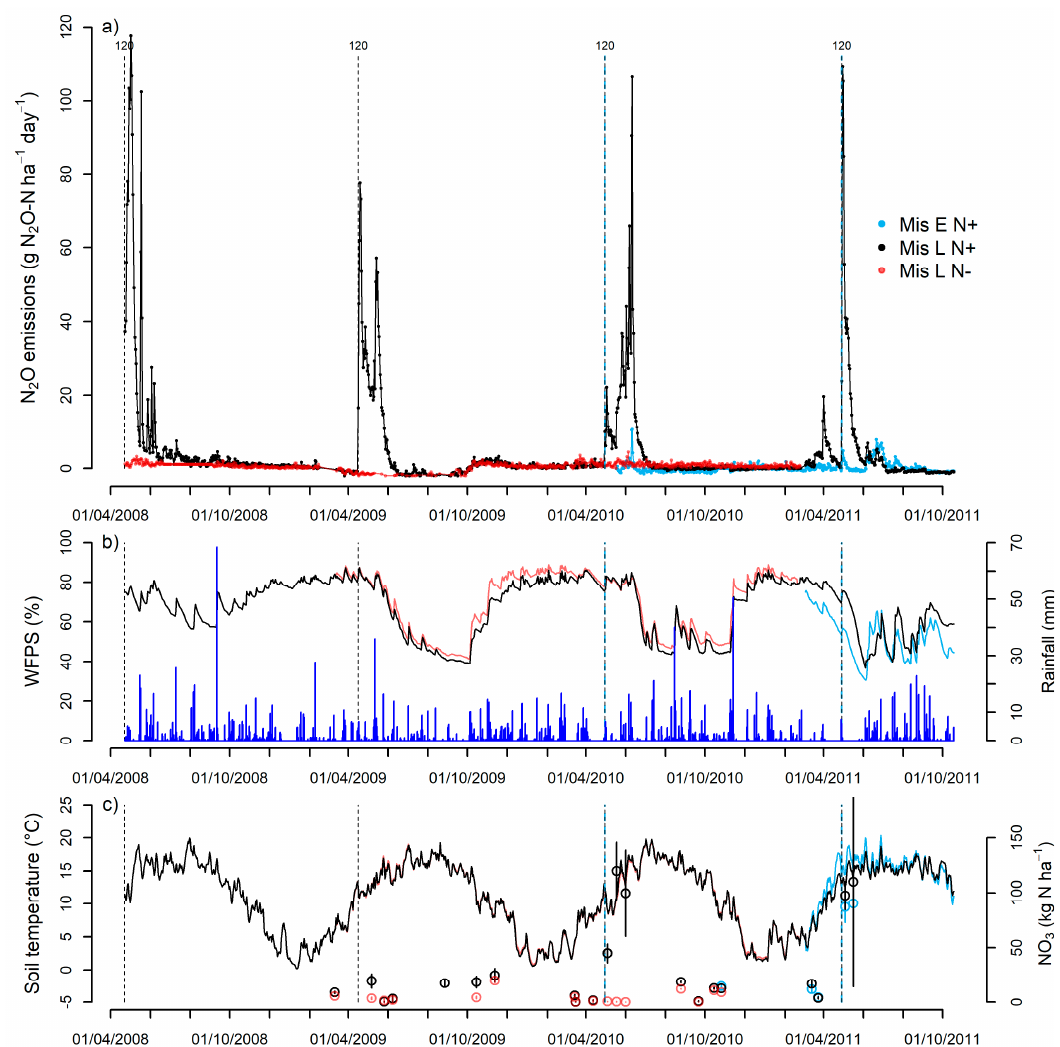
Figure 2. Daily N 2 O emissions ( a ); daily rainfall and WFPS (0–30 cm) ( b ); and daily soil temperature (15 cm) and soil nitrate content (0–30 cm) ( c ) under miscanthus: Mis E N + (green), Mis L N + (red) and Mis L N − (blue). Each point in ( a ) represents a measured value (daily average). Vertical dotted lines represent fertilization events with the N rate in kg N ha − 1 . Vertical lines in ( c ) represent the standard deviations for soil nitrate content. WFPS and soil temperature for Mis E N + were not available in 2010. See Table 1 for treatment abbreviations.